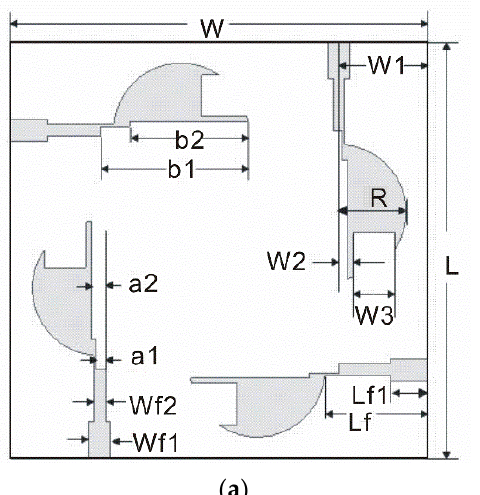
Figure 5. ant5: ( a ) geometry; ( b ) S-parameters. The schematic diagram of the final proposed antenna (ant5) is shown in Figure 6. The antenna’s geometric parameters are listed in Table 1.